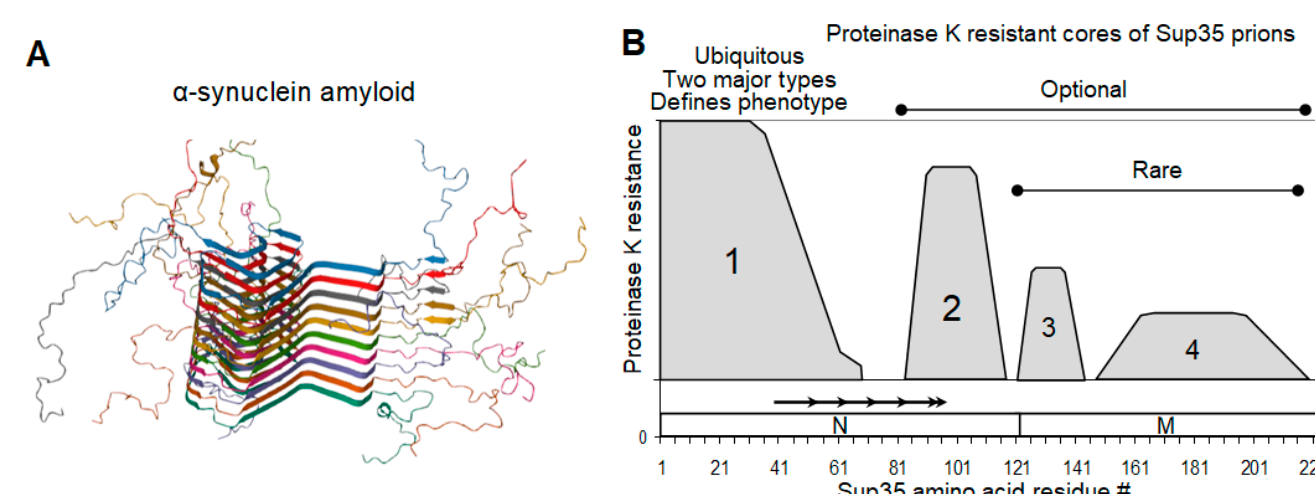
Figure 1. α -synuclein amyloid and Sup35 prion structure. ( A ) A typical parallel in-register amyloid structure exemplified by that of α -synuclein (PDB 2N0A) [48]. ( B ). Map of proteinase K-resistant cores of Sup35 prions. The picture summarizes data for 26 [ PSI + ] isolates differing in their origin and phenotype [45]. The location of Sup35 N and M domains, as well as of the imperfect oligopeptide repeats, is shown.